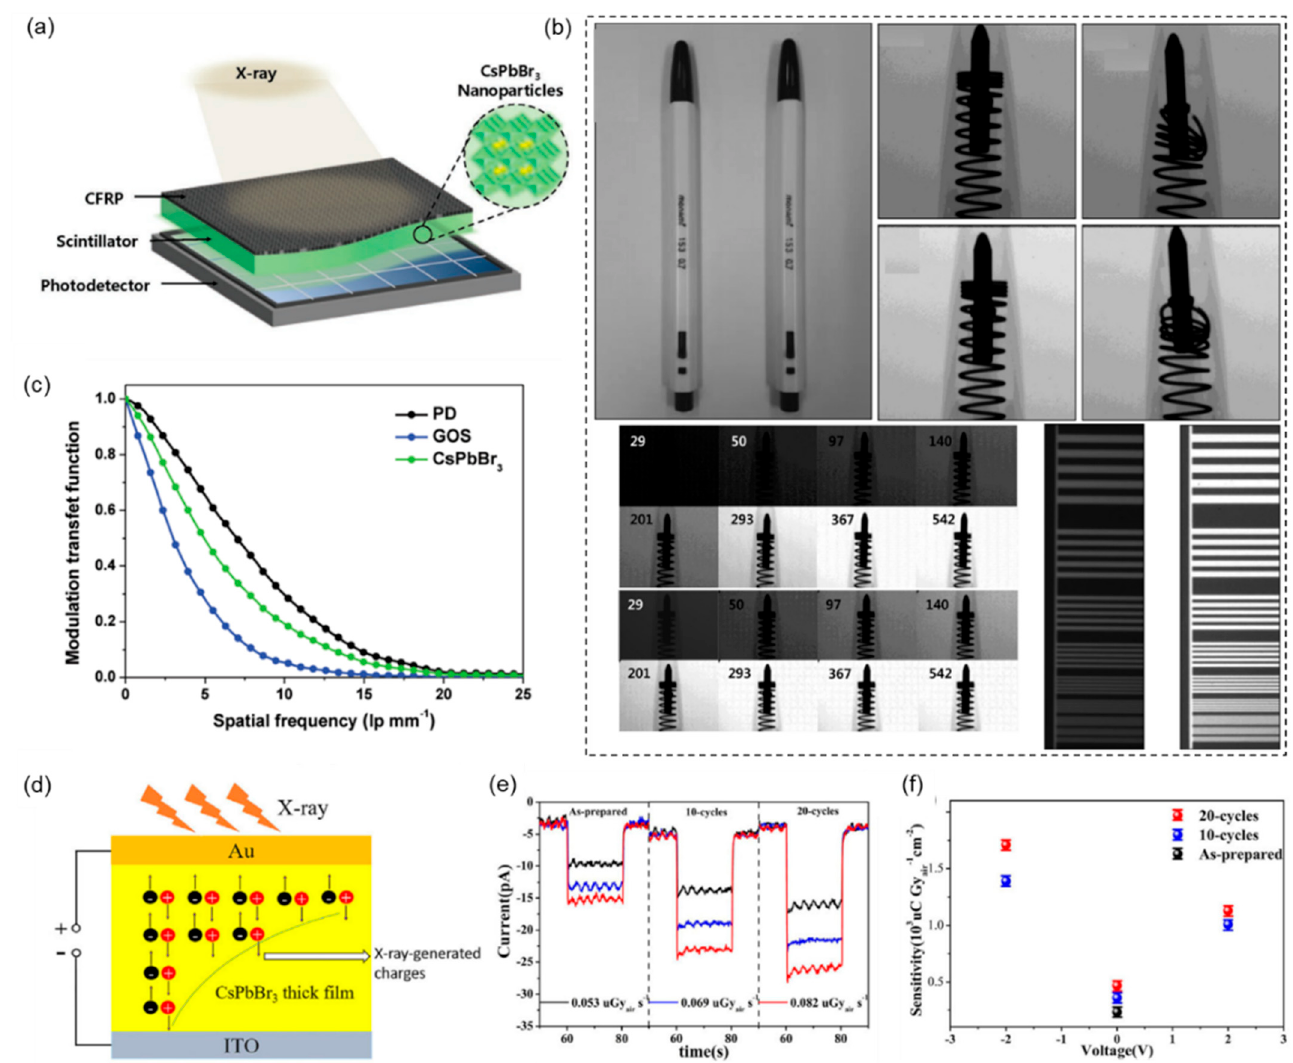
Figure 5. 3D all-inorganic perovskites-based X-ray detectors. ( a ) Schematic diagram of the structure of a CsPbBr 3 perovskite nanocrystalline scintillation X-ray detector. Reprinted with permission from Ref. [55]. 2018, Wiley. ( b ) Photographic and X-ray images for nondestructive inspection. Images of a normal ballpoint pen ( left ) and defective ballpoint pen ( right ) with identical appearance, ballpoint pen X-ray images from conventional GOS scintillator X-ray detectors, ballpoint pen X-ray images from CsPbBr 3 scintillator X-ray detectors, ballpoint pen X-ray images from GOS and CsPbBr 3 scintillator X-ray detectors with X-ray dose rates, line plots taken by GOS and CsPbBr 3 scintillation X-ray detectors. Reprinted with permission from Ref. [55]. 2018, Wiley. ( c ) MTF of the original silicon-based detector, CsPbBr 3 , and conventional GOS scintillation X-ray detector. Reprinted with permission from Ref. [55]. 2018, Wiley. ( d ) Thick film radiation detector structure. The charge-producing region lies inside the thick film and is used for X-ray excitation. Reprinted with permission from Ref. [26]. 2019, Wiley. ( e ) Zero bias light response of raw and treated film at different dose rates. Reprinted with permission from Ref. [26]. 2019, Wiley. ( f ) The sensitivity of a device under different bias voltages and fixed emissivity (0.053 μ Gy air s − 1 ). Reprinted with permission from Ref. [26]. 2019, Wiley.